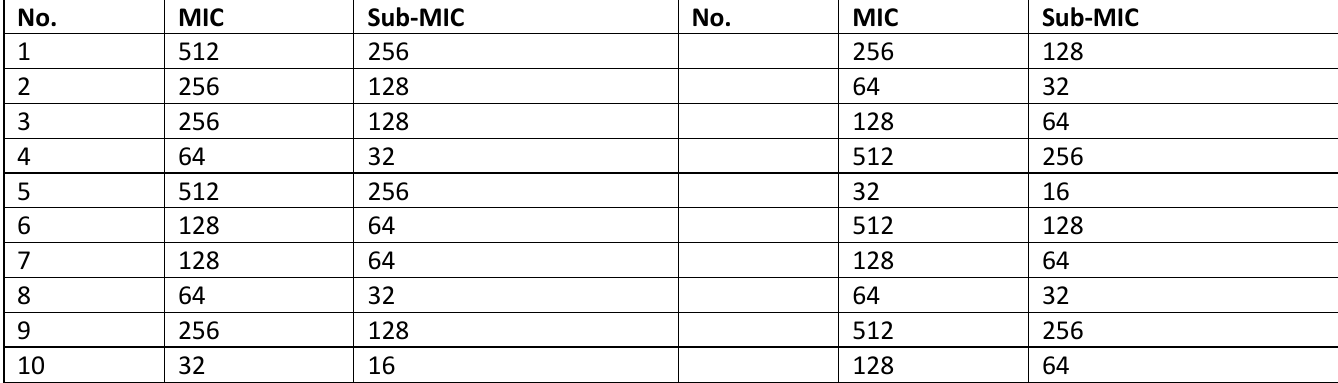
Table 1. MIC and sub-MIC of Ciprofloxacin for Staphylococcus